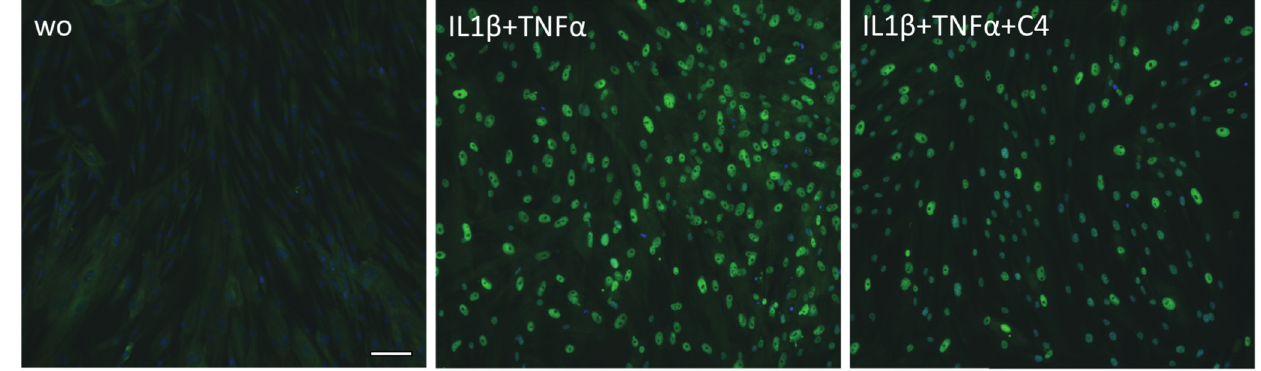
Figure 7. Butyrate decreased the nuclear translocation of p65 in gingival fibroblasts and HSC2 cells . ( A ) Gingival fibroblasts and ( B ) HSC2 oral epithelial cells were exposed to 10 ng/mL IL1 β and TNF α with and without 10 mM butyrate (C4). Immunofluorescence of nuclear translocation of NF- κ B p65 into the nucleus is indicated by green staining. Cells with no or low p65 nuclear translocation appear blue. “wo” means “without” and represents unstimulated cells. Scale bar is 100 µm. 3. Discussion SCFAs are well-recognized in periodontal research for two reasons: reason one is that propionic and butyric acid are metabolic by-products of anaerobic bacteria reaching ap- proximately 10 and 3 mM, respectively, in the periodontal pocket of diseased subjects [15,16]. Reason two is that butyrate and propionate isolated from dental plaque extracts are harmful to various cell types related to the periodontium in vitro [8–13] but, on the other hand, have potential beneficial effects, particularly when acting systemically [17– 22]. The current study provides further evidence to support a role for SCFAs in the control of the inflammatory response of periodontal cells. We initially established a bioassay showing that butyrate reduced the P. gingivalis LPS-induced expression of IL6 and CXCL2 in RAW 264.7 macrophage-like cells. We extend the original bioassay to primary macro- phages where, again, butyrate significantly attenuated the P. gingivalis fimbriae- [28–30] and saliva-induced [31] expression of IL6 and CXCL2. Thus, butyrate, but not the other SCFAs, is a potent inhibitor of a forced inflammatory response of macrophages in vitro. With respect to gingival fibroblasts and HSC2 oral squamous epithelial cells exposed to IL1 β and TNF α , the overall situation was less obvious. We can report that, in gingival fibroblasts, butyrate significantly reduced IL8, CXCL1, and CXCL2 expression, even though acetate and propionate showed a trend in this direction. Moreover, in oral epithe- lial HSC2 cells, butyrate and propionate significantly reduced CXCL1 and CXCL2 chem- okines. Taking advantage of these bioassays, our data propose that butyrate in particular suppressed the in vitro inflammatory response in cell types relevant in periodontology. These findings are important because they add to the controversial discussion of whether or not SCFAs protect the periodontal tissue or push the catabolic process [8,39].